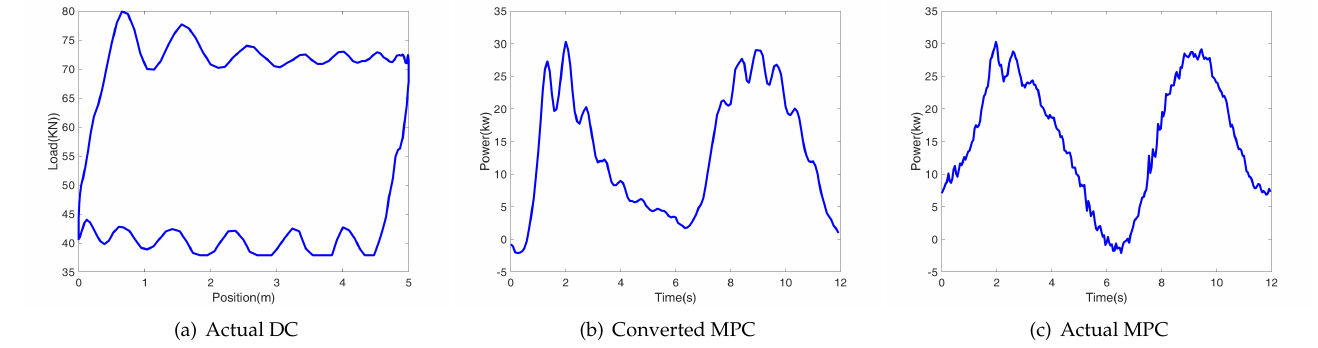
Figure 6. Normal working state.